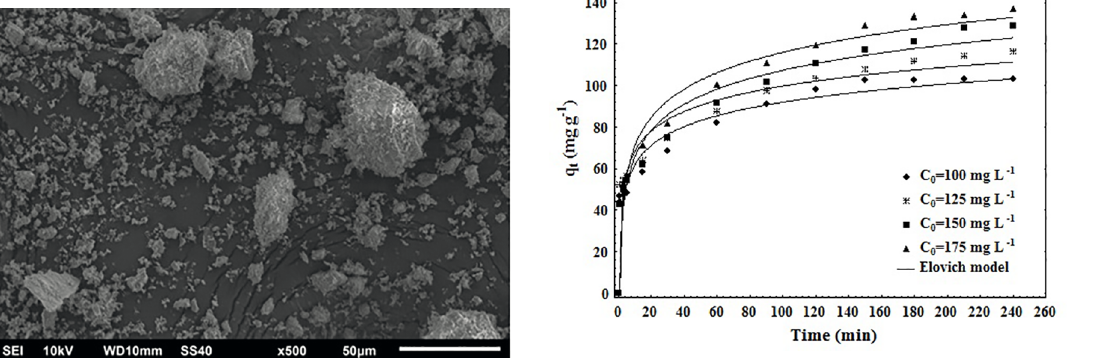
Figure 6. SEM image of raw kaolin.